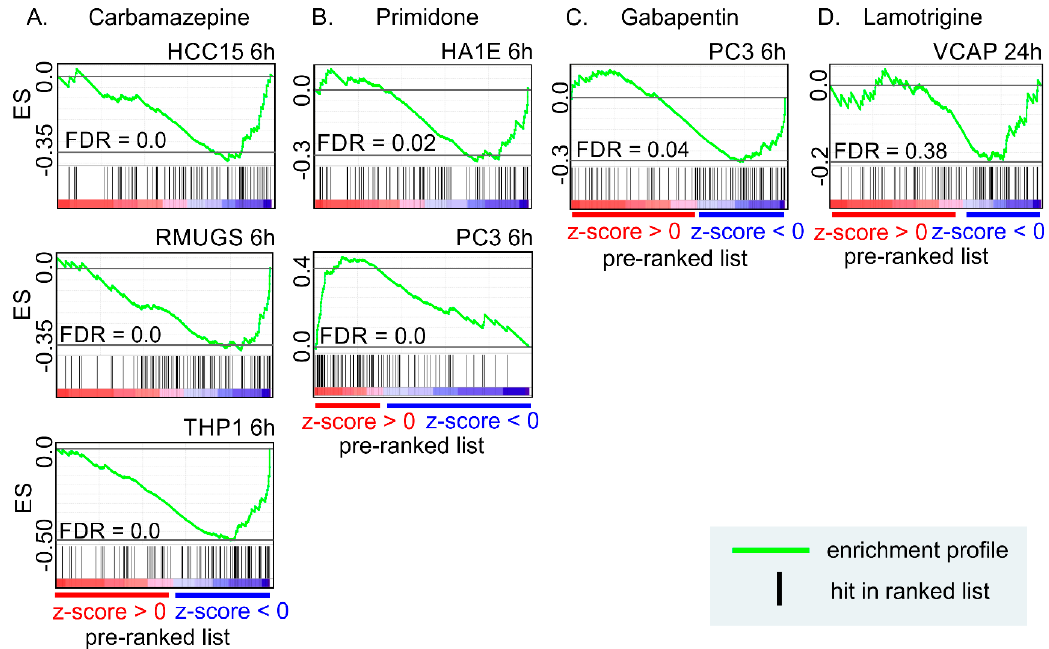
Figure 3. The effect of four anti-seizure drugs on EV-related genes in cell lines. The gene expression profiles of the anti-seizure drugs were downloaded from the LINCS database and used to prepare a rank lists for the Gene Set Enrichment Analysis. The top100 EV-related proteins from Vesiclepedia (http://microvesicles.org/, accessed on: 1 December 2018) were used as a gene set. ( A ) EV-related genes were negatively enriched by carbamazepine in the HCC, RMUGS, and THP1 cell lines. ( B ) Primidone treatment induced a negative enrichment in the HA1E cell line and a positive enrichment in the PC3 cell line. ( C ) Gabapentin treatment induced a negative enrichment. ( D ) Lamotrigine treatment did not show any enrichment of genes. ES, enrichment score; FDR, false discovery rate; HCC, Hepatocellular carcinoma cell line; HA1E, Cellosaurus cell line; PC3, human prostate cancer cell line; VCAP, human prostate cancer cell line; RMUGS, Cellosaurus cell line; THP1, human leukemic monocyte cell line.